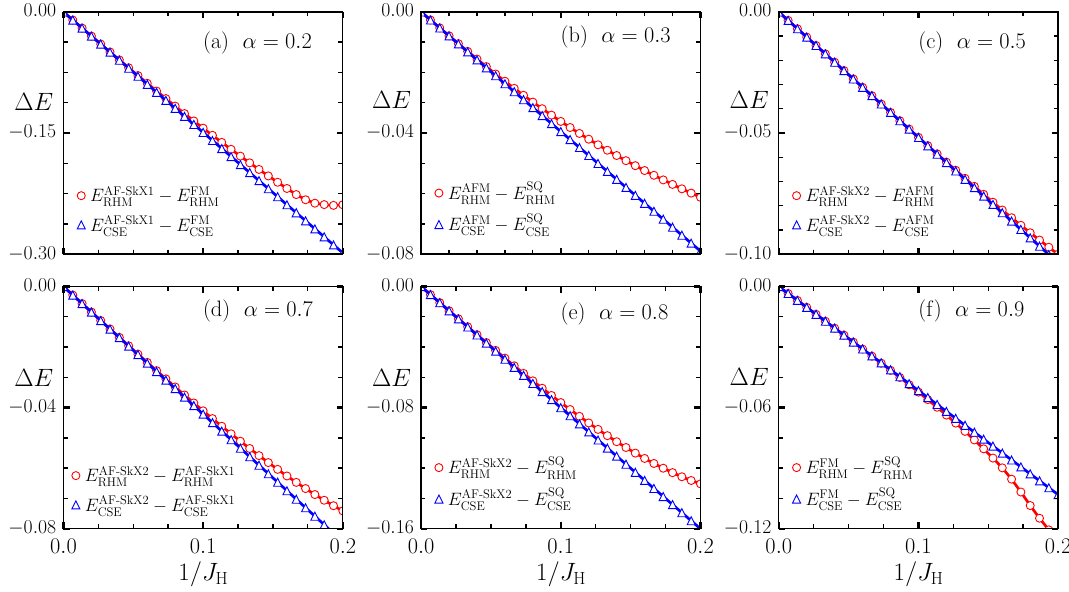
Figure 2. Energy difference, (cid:31) E , between different pairs of magnetic states, calculated within exact RHM and the derived classical super-exchange model (CSE), for various α values. The magnetic phases considered to calculate the energy differences are antiferromagnetic (AFM), ferromagnetic (FM), single-Q (SQ), and antiferromagnetic skyrmion states (AF-SkX1, AF-SkX2) states. All energies are measured in units of the bare 1 hopping parameter t 0 =